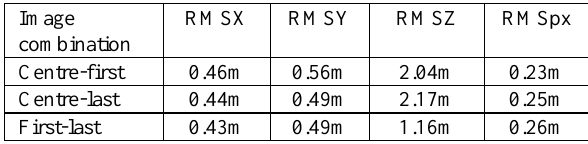
Table 3: Root mean square differences at GCP in image model The achieved accuracy for X and Y in the average of 0.45m corresponds to 0.64 geometric pixels (0.7m GSD) or 0.90